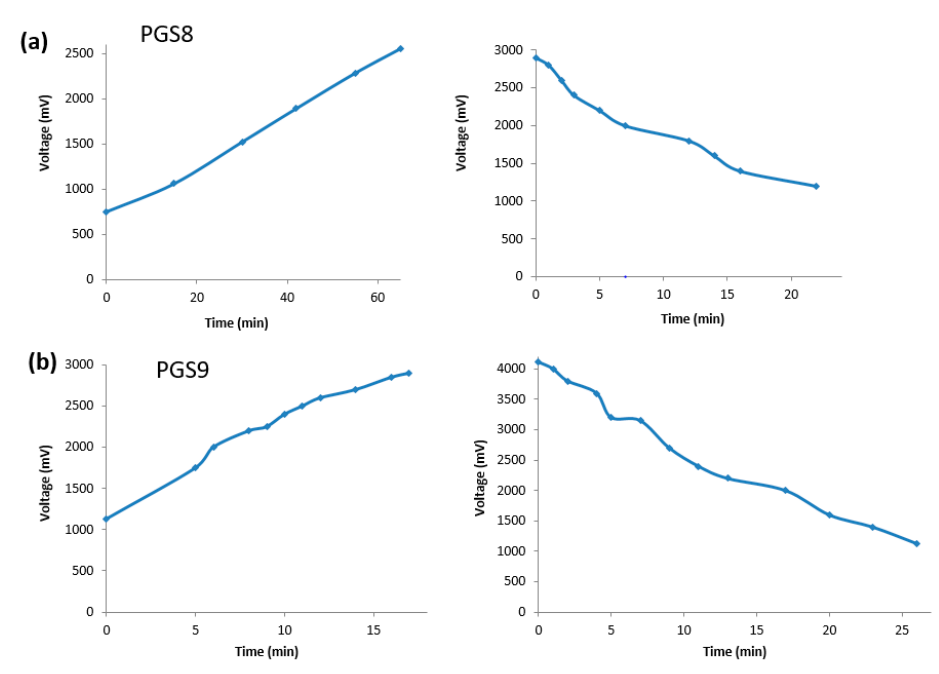
Figure 14. Plots of the dynamic responses of PGS8 and 9 pH sensor candidates versus time and their respective inverse decrease time: charge and discharge for ( a ) PGS8 and ( b ) PGS9. The sheets were powered by a constant current of 20 V.